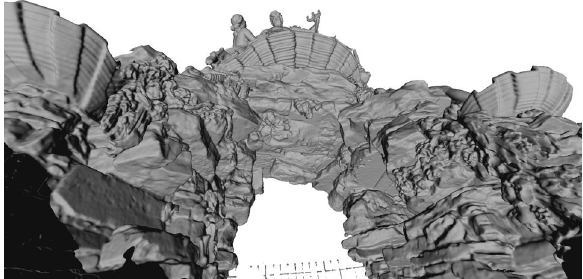
Figure 6. Triangulation detail showing the richness in detail of the model.